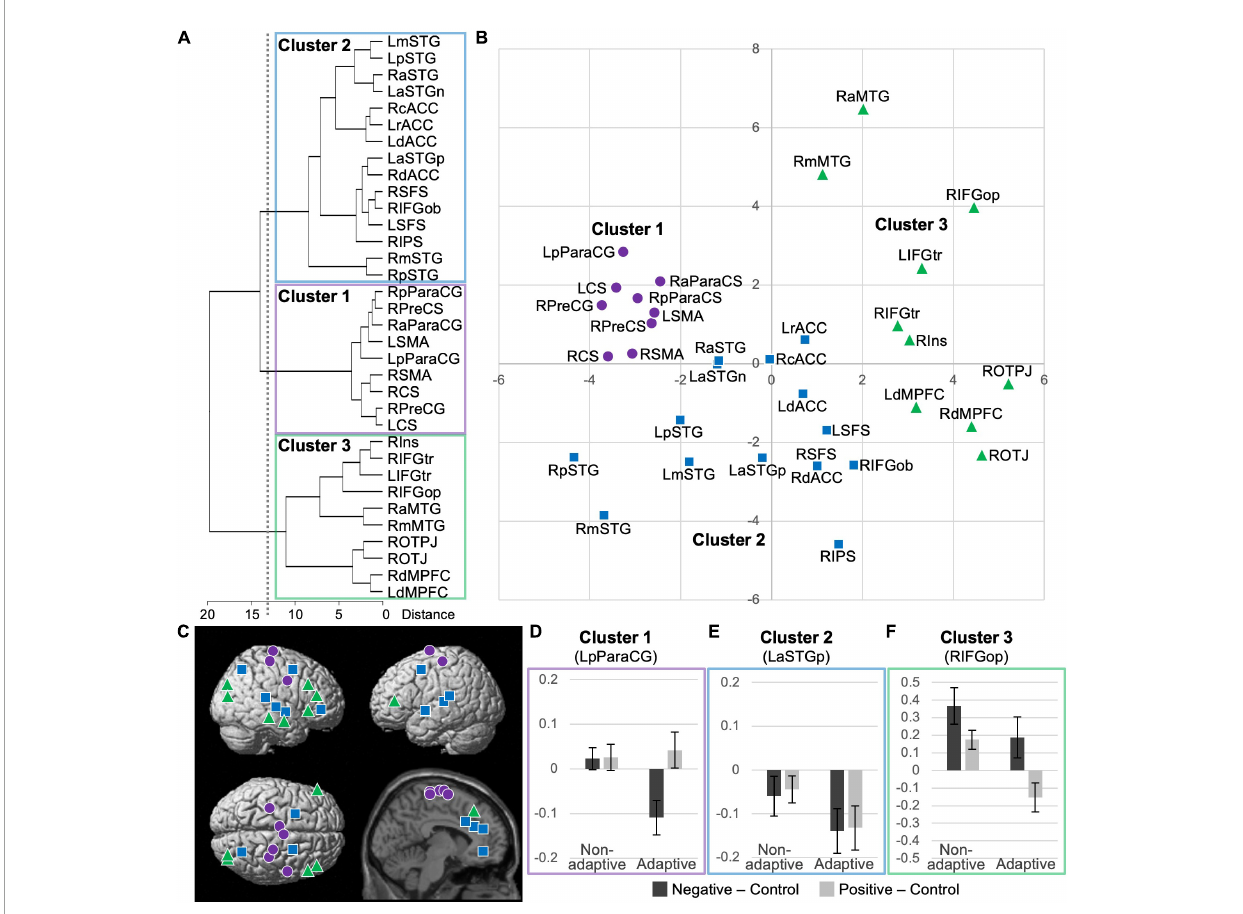
FIGURE3 Results of cluster analysis of 34 identified regions with significant trait effects based on t -values for trait effect and average activation for emotional responses in two valences. (A) Dendrogram of the hierarchical cluster analysis; a threshold of 13.96 for between-cluster distances (dotted line) resulted in a three-cluster solution. (B) Two-dimensional plots of principal components. See Tables 1 , 2 for anatomical labels. (C) Anatomical locations of the peaks, indicated by cluster-specific symbols. (D–F) Activation profiles of the representative regions of clusters 1–3 (i.e., the posterior left paracentral gyrus, the anterior left superior temporal gyrus, and opercular part of the right inferior frontal gyrus, respectively). Average emotional responses for two valences are shown separately for non-adaptive ( n = 20) and adaptive ( n = 20) groups, based on a median-split of low and high emotion regulation scores,